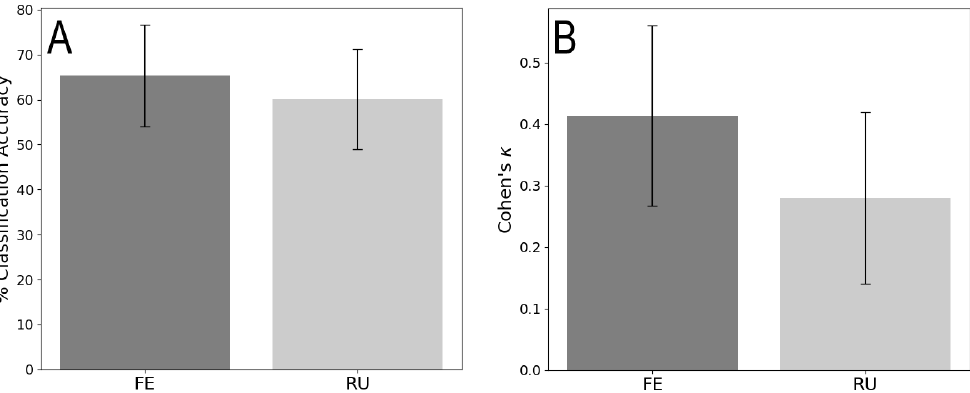
Figure 7. Mean test accuracy ( A ) and Cohen’s κ ( B ) for flexion/extension (FE) and radial/ulnar deviation